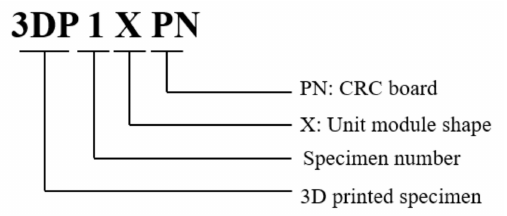
Figure 11. Definition of test specimen